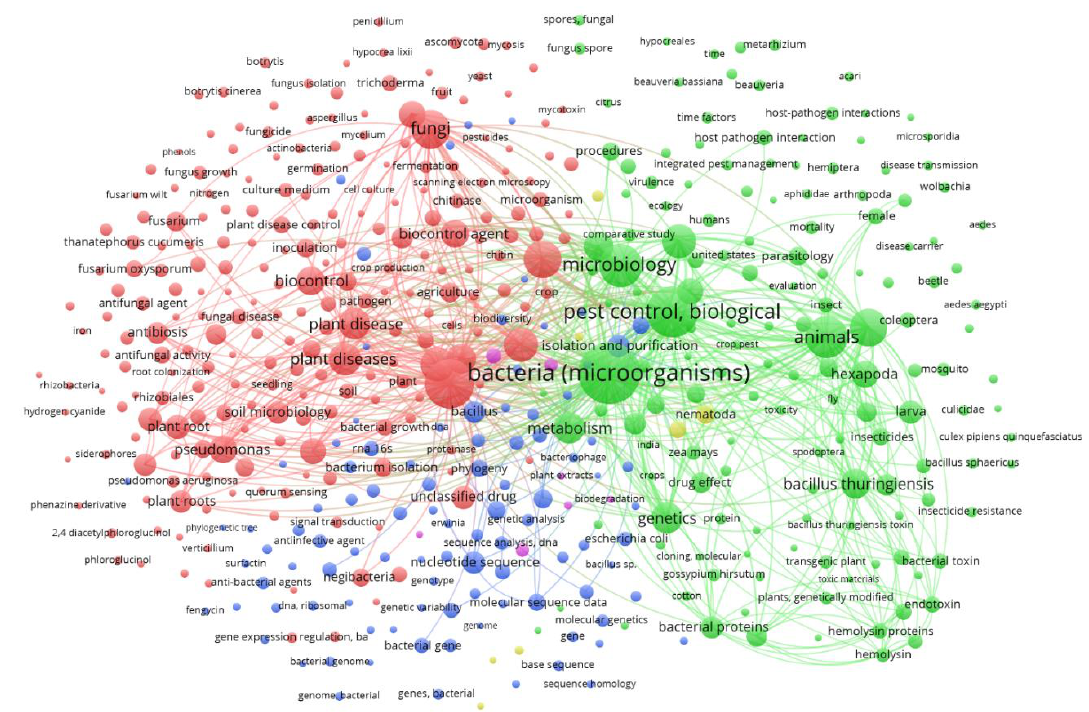
Figure 4. VOSviewer overlay visualization for “biological pest control” and “microorganism” from 1998 to 2020 (18 September).